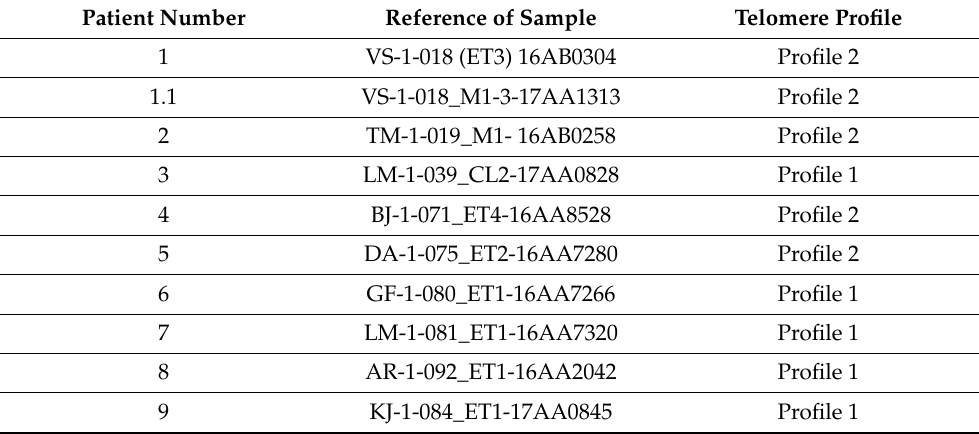
Table 2. List of all patients with their corresponding telomere profile groups. Patient Number Reference of